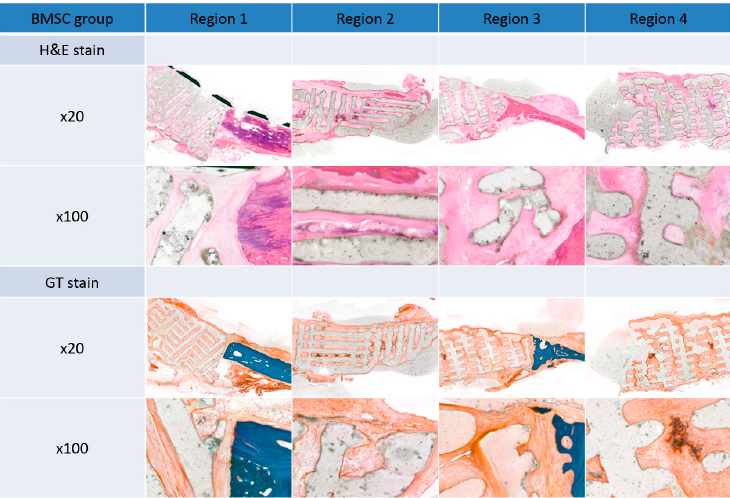
Figure 8. Histopathological analysis of the bone marrow stem cell (BMSC) group 12 weeks after surgery by Hematoxylin and Eosin (H&E) and Goldner’s trichrome (GT) staining. Original magnification: ×20 and ×100.